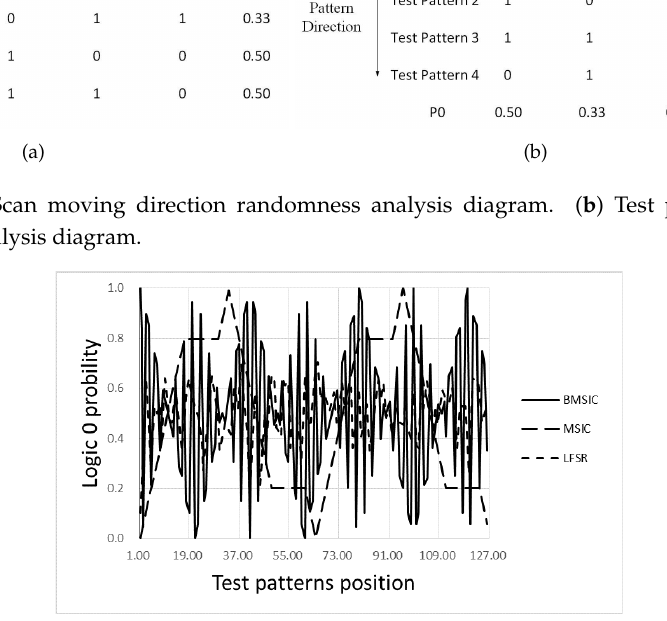
Figure 5. Scan moving direction Logic “0” probability distribution.